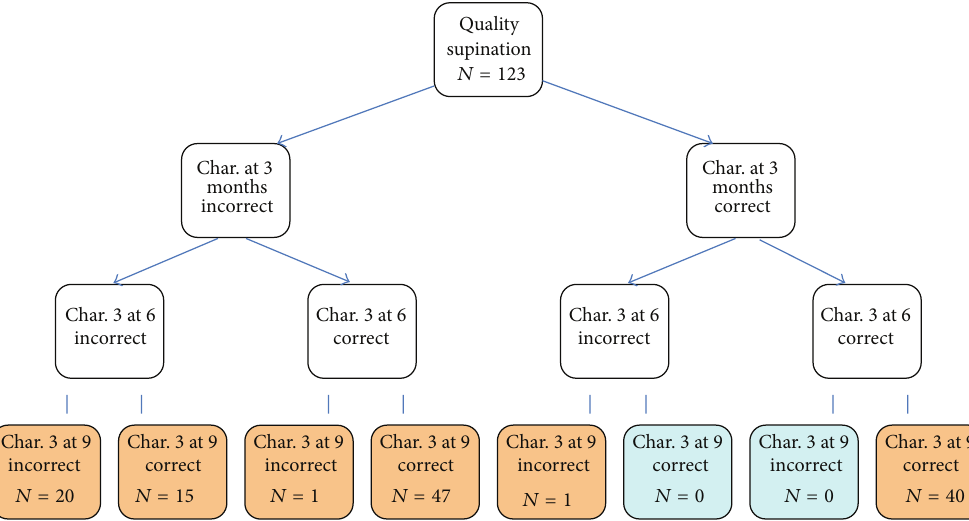
Figure 2: Analysis of qualitative development in the supine position at 3, 6, and 9